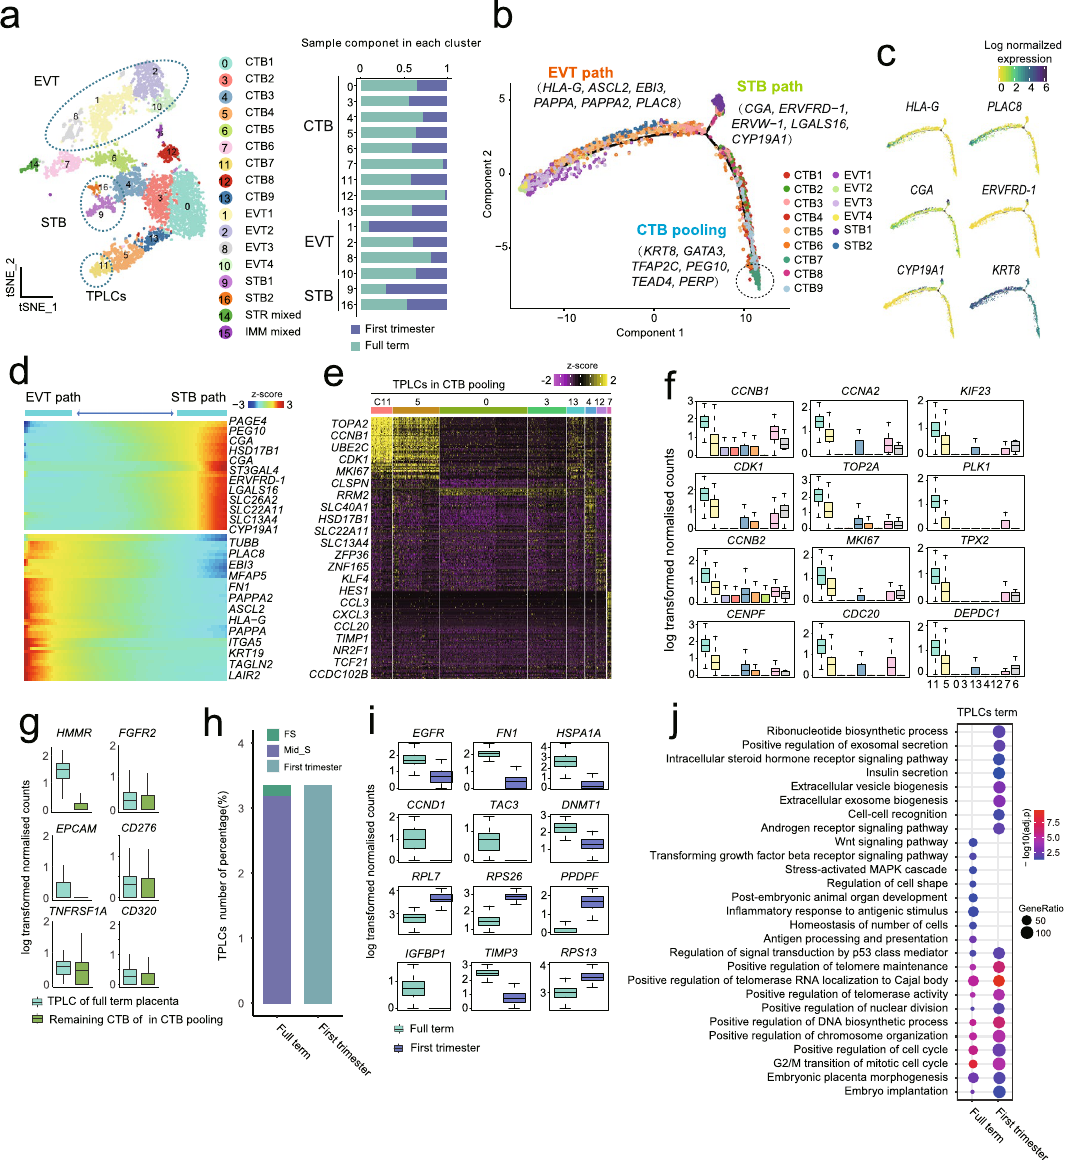
Figure 3. The trophoblast progenitor like cells (TPLCs) existed in human full-term placenta. ( a ) T-distributed stochastic neighbor embedding (t-SNE) visualization of trophoblast cells from integrated data of full-term placenta cells and the published first-trimester placenta cells shown in Supplementary Fig. 3a. On the right, the barplot shows the proportion of full-term placenta cells and first-trimester placenta cells in each cluster and each cell type. ( b ) Monocle 2 (version 2.10.1) for pseudotime ordering of trophoblast subgroups that reveals EVT and STB pathway and visualization in biaxial scatter plot. ( c ) Expression pattern of selected genes across trophoblast differentiation branches on the reconstructed trajectory. Color scheme is based on log-transformed, normalized expression levels. ( d ) Heatmap showing the expression levels of selected differentially expressed genes that are identified as significantly involved in EVT and STB differentiation pathway. Color scheme is based on relative gene expression (z-score). ( e ) Heatmap shows the differentially expressed genes among CTB subpopulations, in which one small cluster (C11, termed as TPLCs) shows highly expressed cell cycle-related genes. ( f ) Boxplot showing the log-transformed, normalized expression of genes selected from ( e ). ( g ) Boxplot showing the expression level of selected cell surface genes between TPLCs and other CTB clusters derived from full-term placenta in CTB branch of ( b ). Two-sided Wilcoxon rank sum test were calculated, *: P < 0.05; **: P < 0.01; ****: P < 0.0001. ( h ) Column chart showing the percentage of TPLCs derived from indicated gestation and spatial location of first-trimester and full-term placenta. ( i ) Boxplot showing the differentially expressed genes of TPLCs derived from first-trimester and full-term placenta. Genes were selected from top 50 differentially expressed genes identified by FindAllMarker function in Seurat, P_val_adj < 0.05; avg_logFC > 0). ( j ) Gene Ontology (GO) enrichment analysis showing the selected functional terms of TPLCs derived from first-trimester and full-term